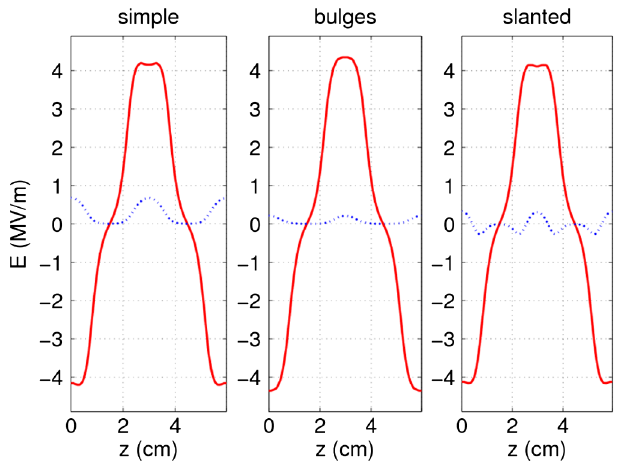
FIG. 9. On-axis electric-field components versus the longitu- dinal coordinate—longitudinal (solid red) and vertical (dotted blue): left and center—for the IH structures in Fig. 8, and right— for that in Fig. 10.